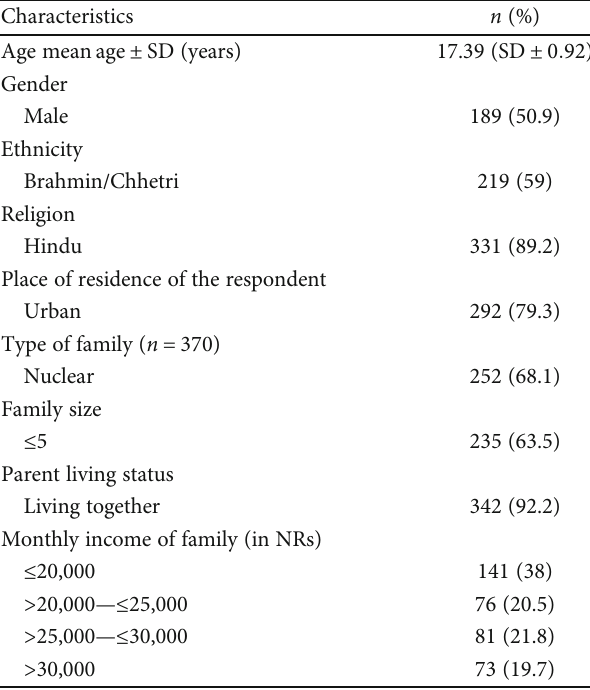
Table 2: Distribution of characteristics of family of respondents ’ ( n = 371